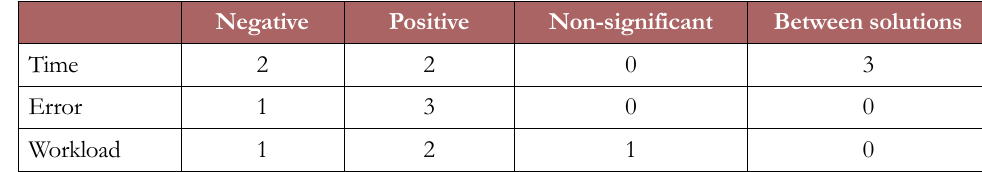
Table 4. Impacts of virtual reality on worker’s performance.